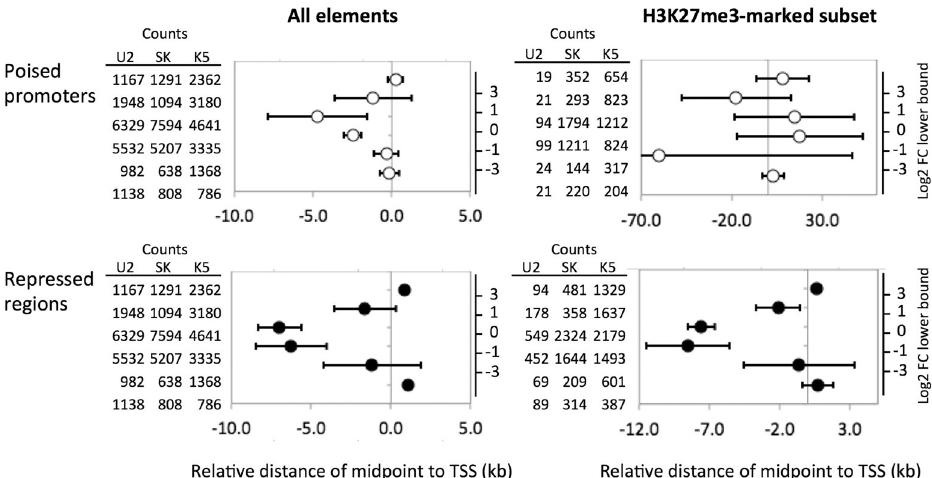
Fig. 6 Distances of nearest chromatin states to TSS ’ s. Genes are strati fi ed by fold-change in expression level after PcTF expression in transiently transfected cells. Numbers of regions nearest the TSS of genes in each category are shown in tables next to each chart. The coordinates of poised promoters, repressed regions, and 11 other states (not shown) were determined using chromatin state classes from the ENCODE project (UCSC Browser HMM track for K562 cells). 35 U2 = U-2 OS, SK = SK-N-SH, K5 = K562